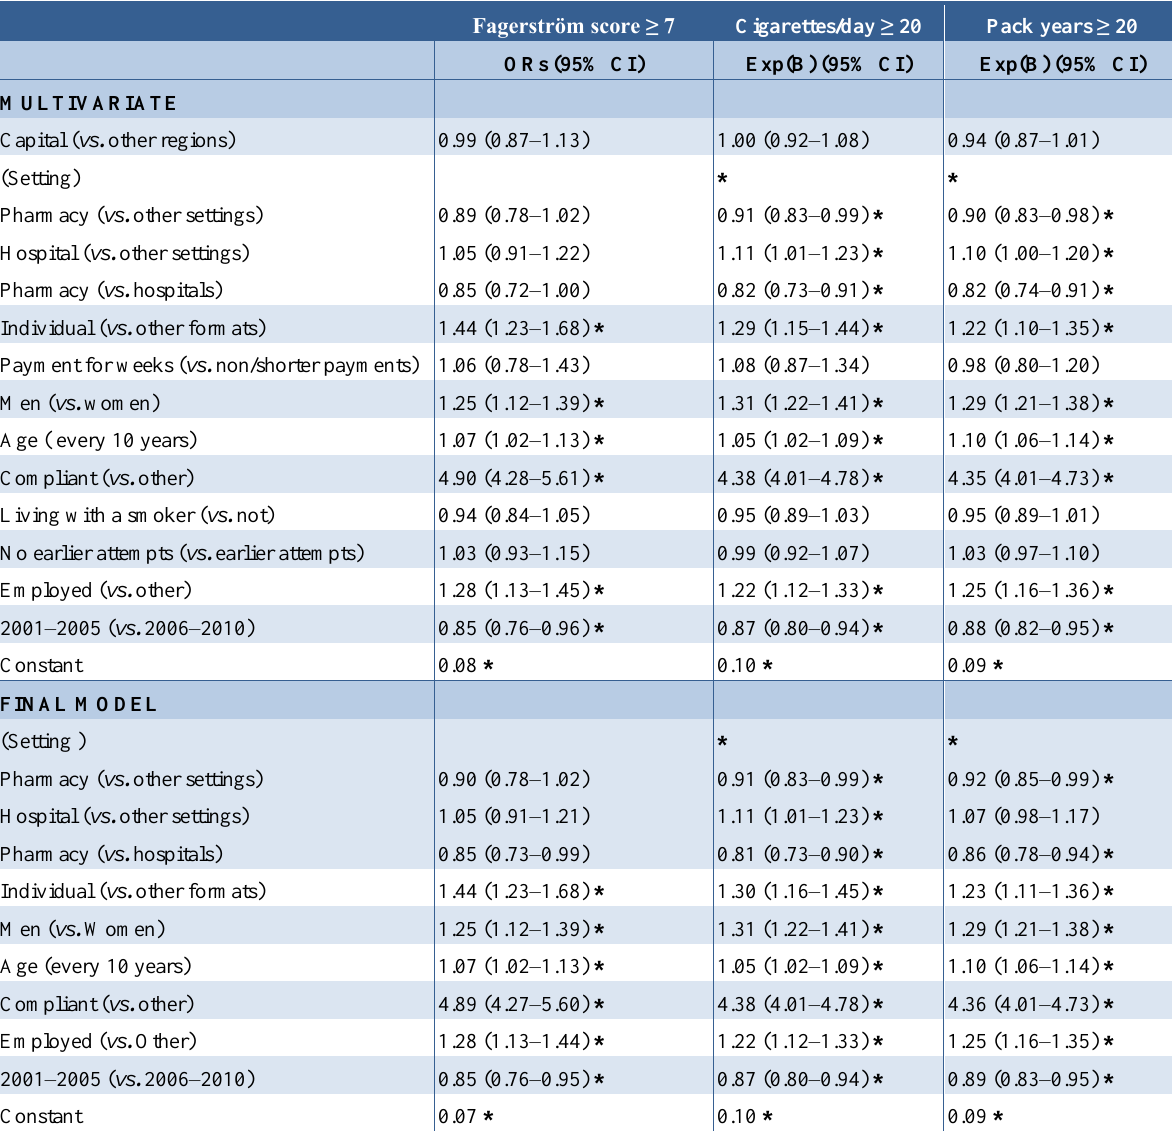
Table 2. Multivariate model and final model after backward elimination for continuous abstinence as the dependent variable. The independent categorical variables were given with the reference category in brackets. (Significant results were additionally marked with an *